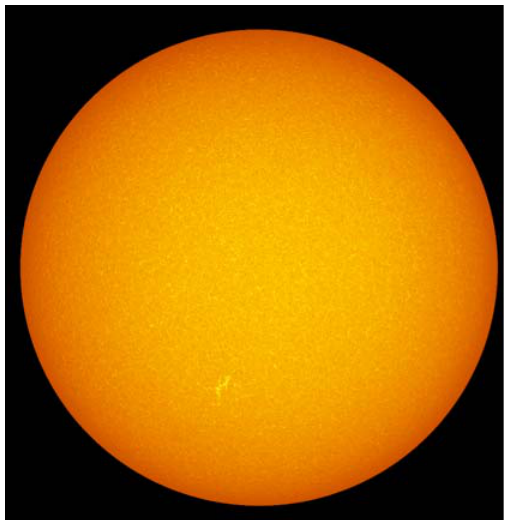
Figure 12. Upper Chromosphere seen via Hydrogen Alpha